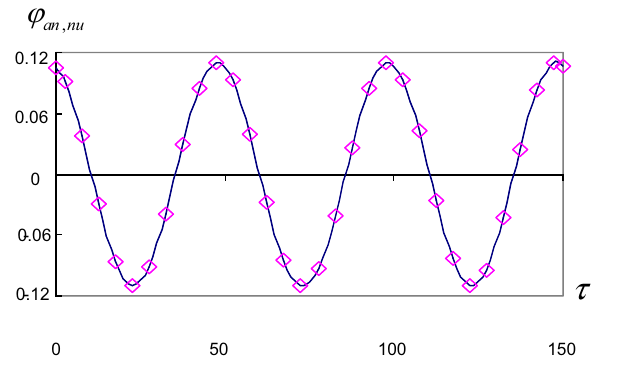
Figure 2. Approximate periodic solutions diagram ( ϕ an , nu , τ ).